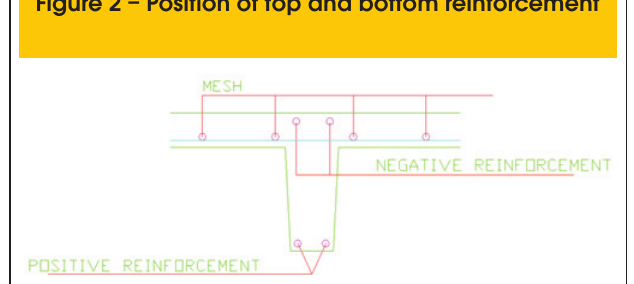
Figure 2 – Position of top and bottom reinforcement